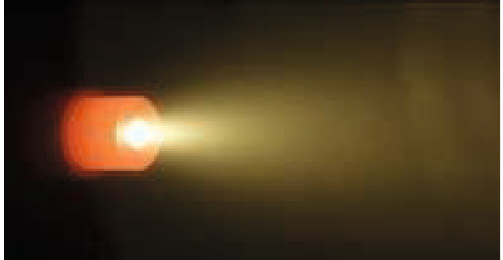
Figure 2: TALOS Arcjet thruster in the University of Stuttgart (NH ) 3